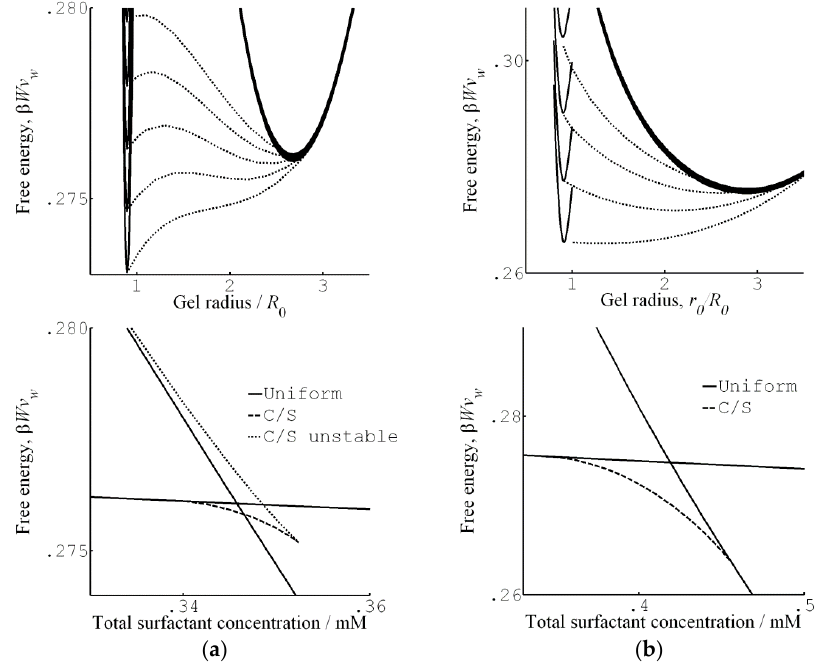
Figure 14. ( a ) Intermediate volume (×700), 10 mM salt. Top: The free energy upon quasi-static volume change, depending on the added concentration of surfactant. Bottom: The locations of the free energy extrema. In a narrow range of concentrations, there is a stable core/shell separation; ( b ) small volume (×200), 10 mM salt. Top: The free energy upon quasi-static volume change of uniform (solid) and C/S state (dotted), depending on the added concentration of surfactant (increasing concentration lowers the curves); β = 1/kT. Bottom: The locations of the free energy extrema. The global minimum is always one of the uniform states. Core/shell is stable regardless of shell shickness. Figure taken from ref. [74]. Reprinted with the permission of AIP Publishing.